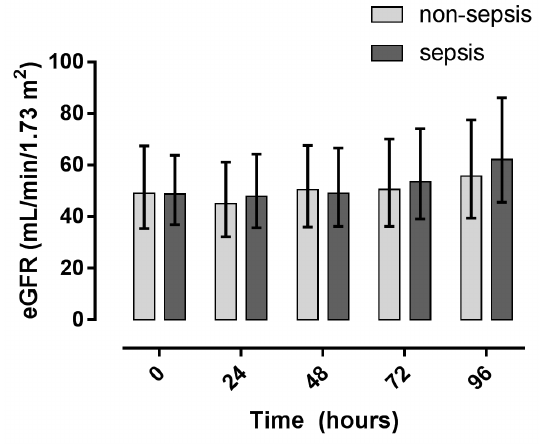
Figure 4: eGFR measurements for non-sepsis and sepsis patients. There are no statistically significant differences between the groups at any time. The data is presented as means with their respective 95%